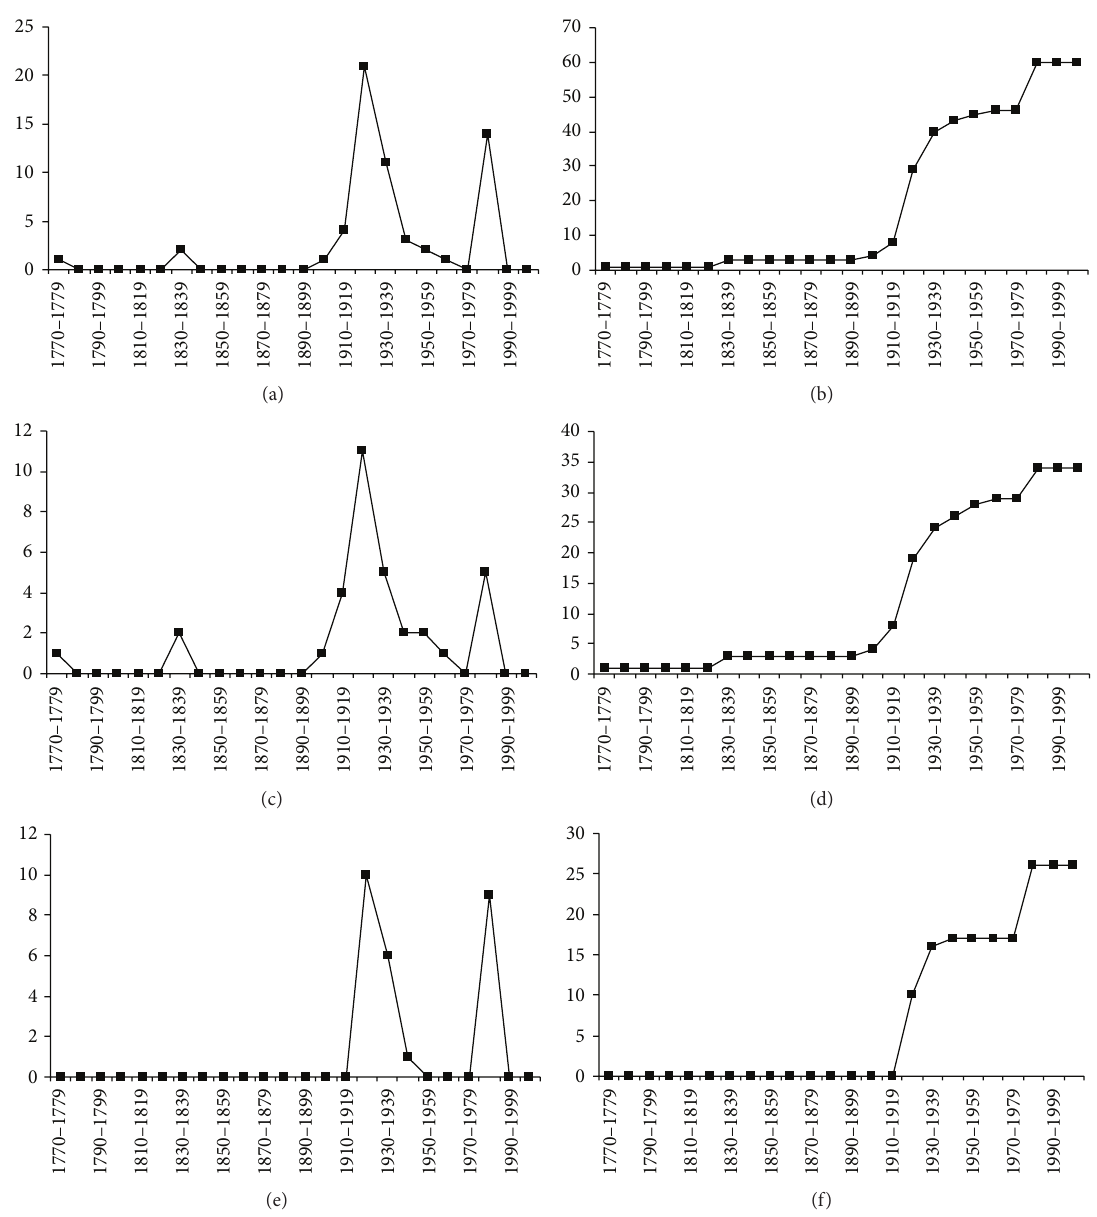
Figure 8: Numbers of total described subgenera (a, b), valid subgenera (c, d), and synonyms (e, f) of Paussini by decades. Figures (a), (c), and (e) report the absolute numbers, and Figures (b), (d), and (f) the cumulative numbers.